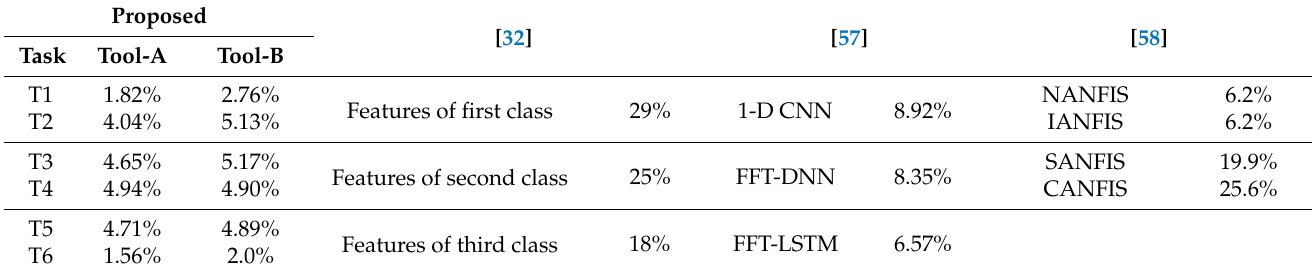
Table 8. MAPE of all six transfer tasks and MAPE of [32,57,58].